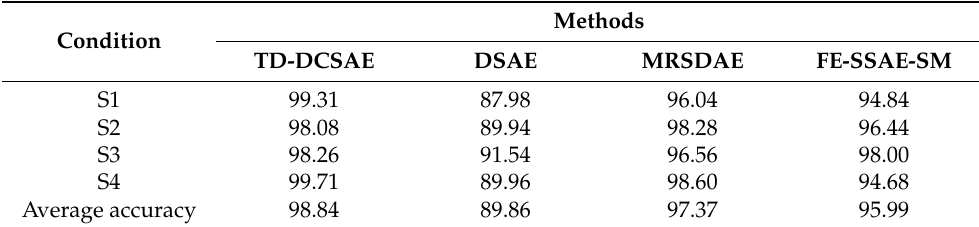
Table 3. The accuracy of different methods under different working condition.